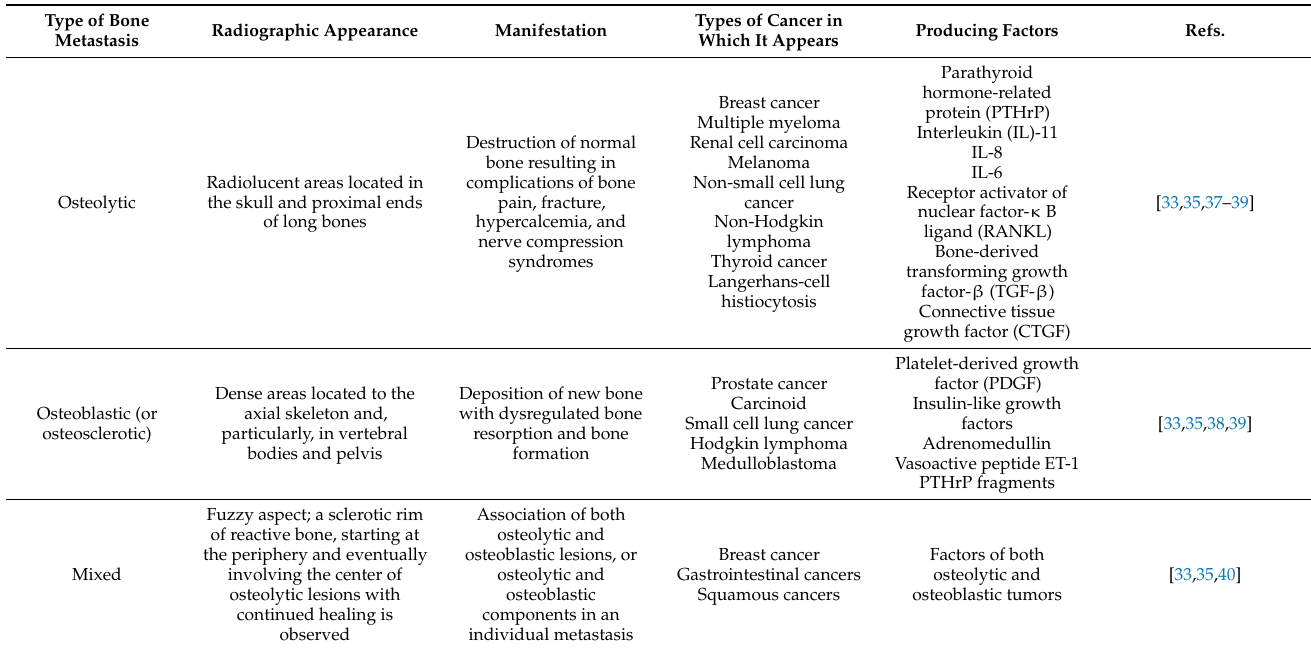
Table 1. Bone metastases—types and characteristics.